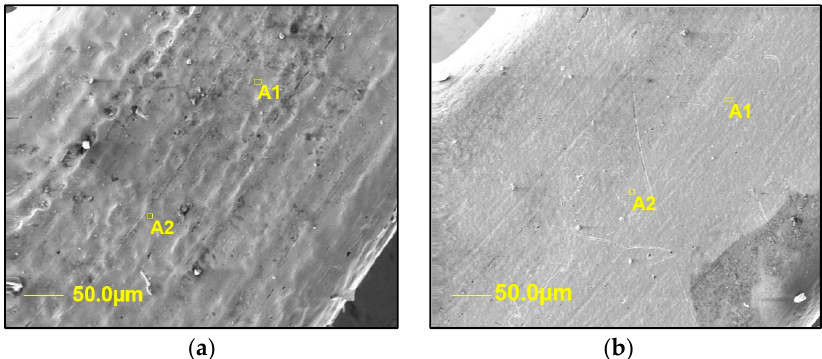
Figure 3 . SEM image of: ( a ) Initial archwire surface (control); ( b ) Deformed archwire surface after the simulation of multiaxial stress equipment (SMAS) simulation test.